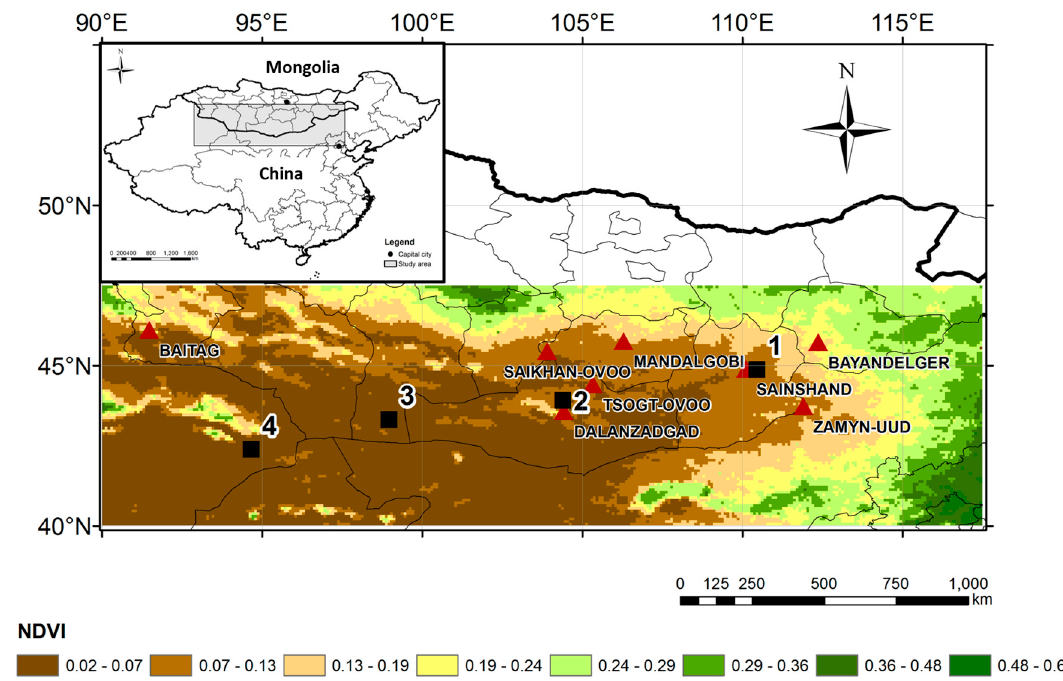
Figure 1. Long-term mean NDVI for the Gobi region (1985–2013) showing the transition from the eastern region with NDVI values of 0.6 to the west with values 0.02. Where, Long-term mean NDVI was averaged monthly maximum NDVI from 1985 to 2013. The numbered locations indicate sites where NDVI data were extracted to examine the temporal variations and trends in NDVI from 1985 to 2013. Furthermore, the red triangles show that the distribution of WMO (the World Meteorological Organization) synoptic stations in Mongolia used for this study. All stations are located in the desert steppe zone of the study area.